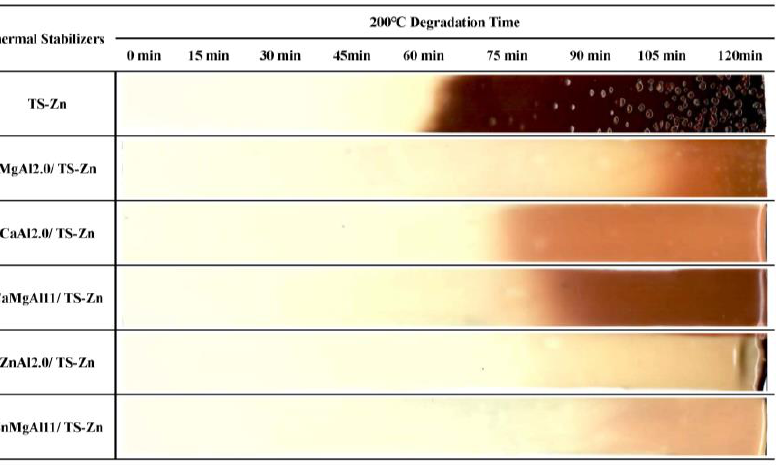
Figure 4. Metal species in laminae of LDHs affect the thermal stability of PVC composites in an oven-aging test.